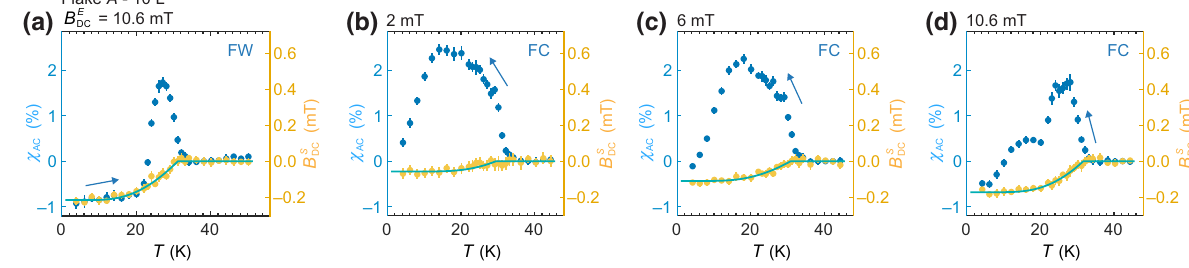
= 10.6 mT. The shape of negative (artifact) χ FIG. 11. Uncorrected χ ac data for Flake A. (a) FW sweep at B E ac background at dc low temperature (blue) tracks the simultaneously measured dc stray field of the flake, B S (orange). The signal due to the phys- dc ical ac magnetization response in the flake is therefore the deviation from a temperature-dependent baseline proportional to the = 2 mT (b), 6 mT (c), and 10.6 mT (d). To determine the baseline corrected flake’s dc field (orange). (b)–(d) FC sweeps at B E dc data for Flake A presented in the main text [Fig. 3(f) inset and Figs. 4(b)–4(d)], B S below T c is first fit to a spin wave model dc β / 2 π JS ) e − (cid:7) 0 / k B T to smooth noise [10]. The fitted curves (shown here in green) are then scaled by the same constant of ∝ S − ( k B S B T dc proportionality, determined by setting the χ ac data in (a) to zero at low temperature, and subtracted from their respective uncorrected χ χ ac . No background correction for ac is performed for Flake C [Fig. 4(a)] or D [Fig. 9(c)] since the dc field from the flake is